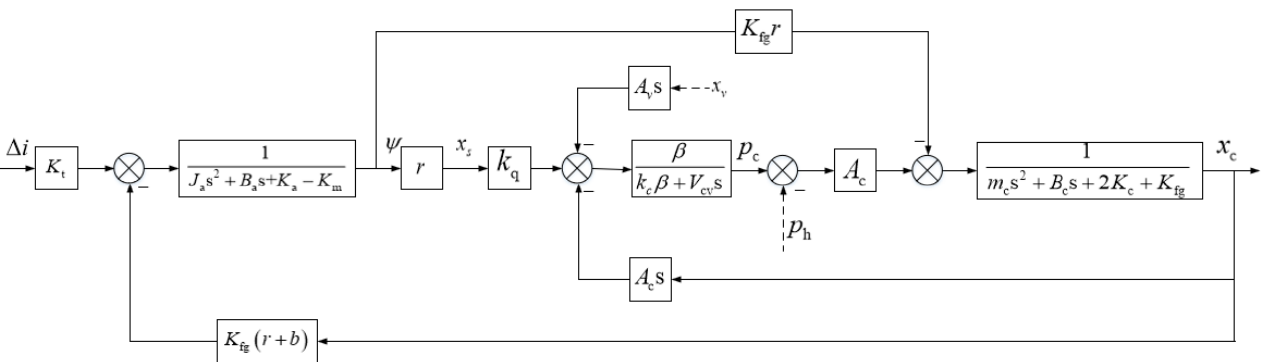
Figure 25. Block diagram of pressure servo valve pre-stage.